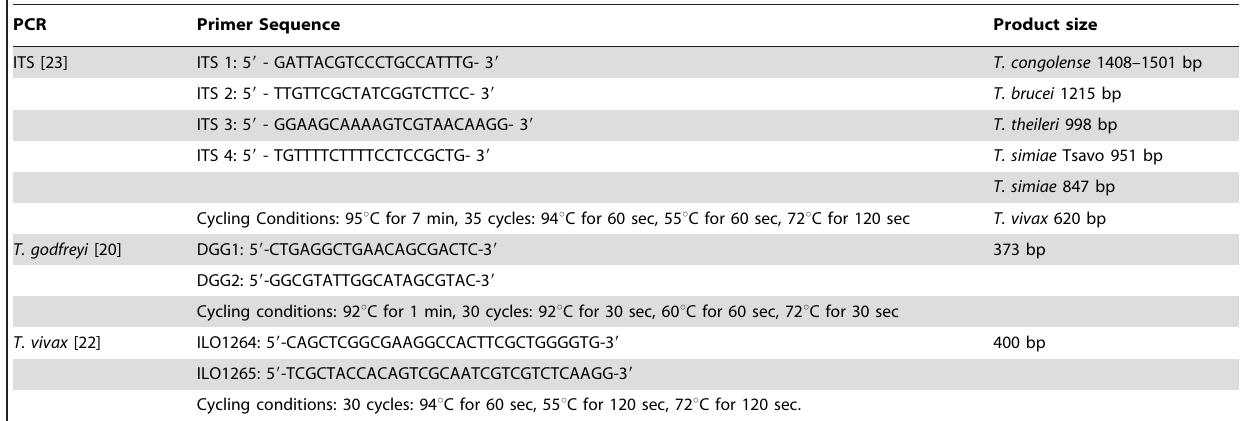
Table 2. PCR primers and cycling